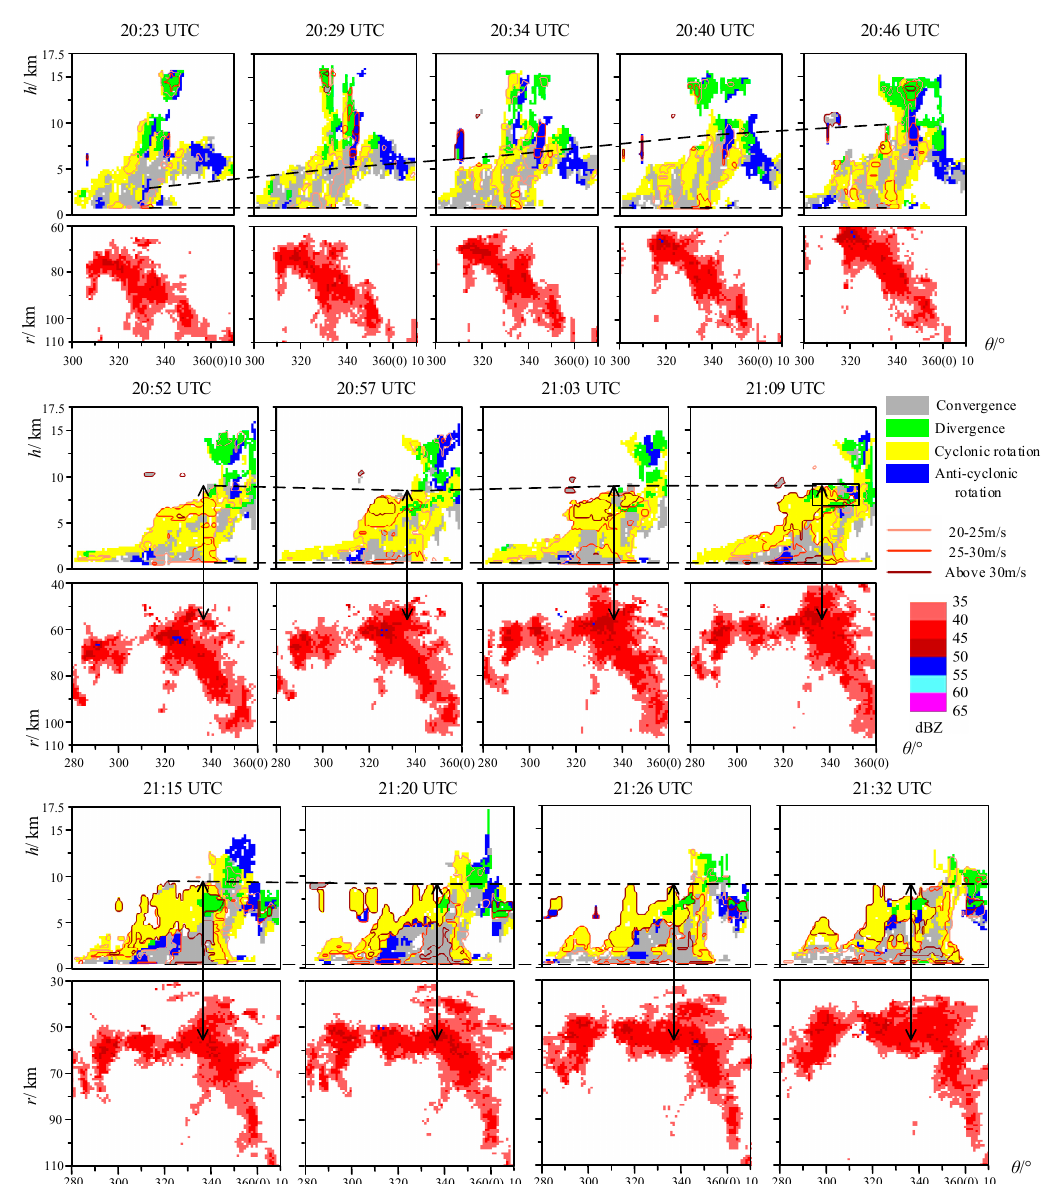
Figure 11. The PMAFSTIs and the corresponding composite reflectivity maps in the θ -r rectangular coordinate system of the shipwreck (1 June 2015). Two black dashed lines in the figure connect, respectively, the highest and lowest points of the high-intensity region in the PMAFSTIs of different moments. The upper ends of the two-way black arrows point to the highest points of the high-intensity region and the lower ends of the arrows point to the position of the shipwreck.